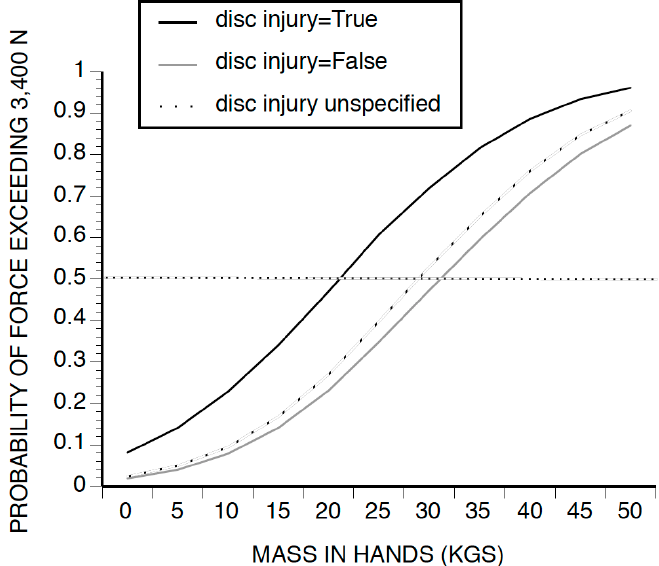
Figure 3. Probability of the L5/S1 compression force exceeding 3,400 N for different evidence (true, false, and unspecified) entered at the disc injury node .